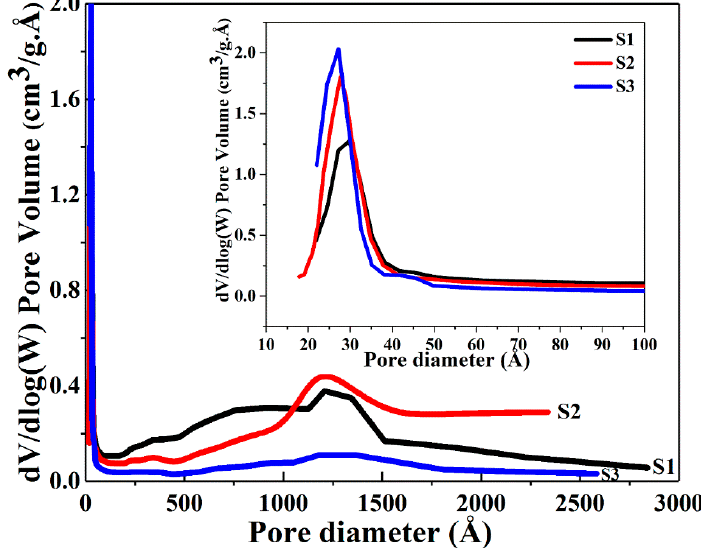
Figure 4. The pore size distribution of the Ag@SiO 2 samples based on BJH desorption dV/dlog (W).